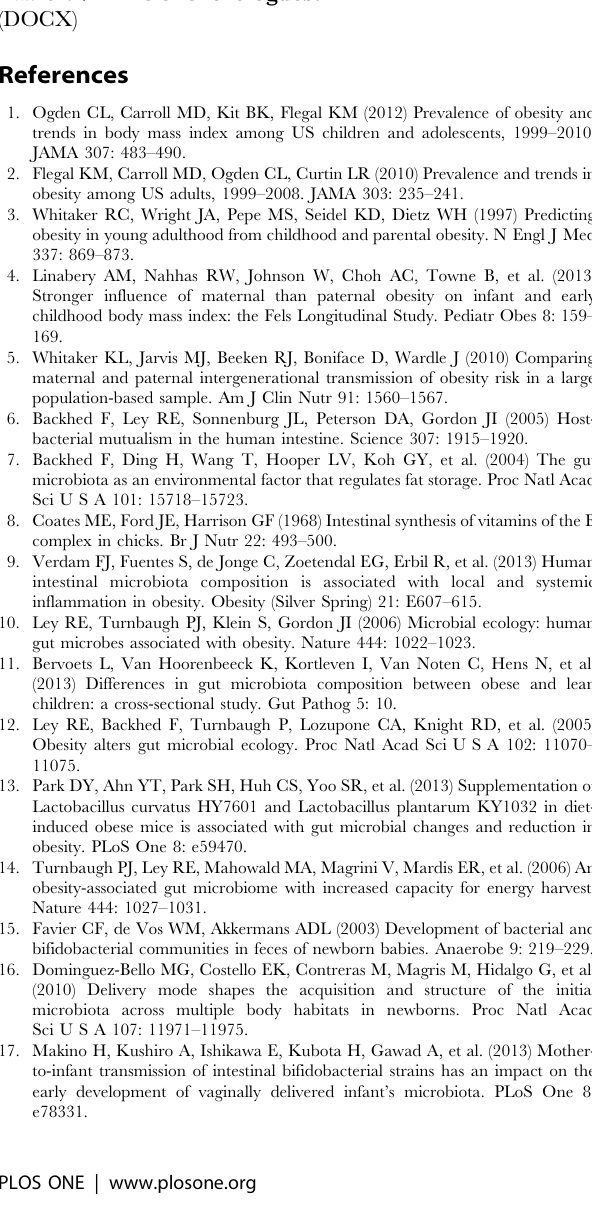
Table S3 KEGG Orthologues among High-Income Sub- jects. Table S4 KEGG Orthologues. Table S5 KEGG Orthologues. Table S6 KEGG